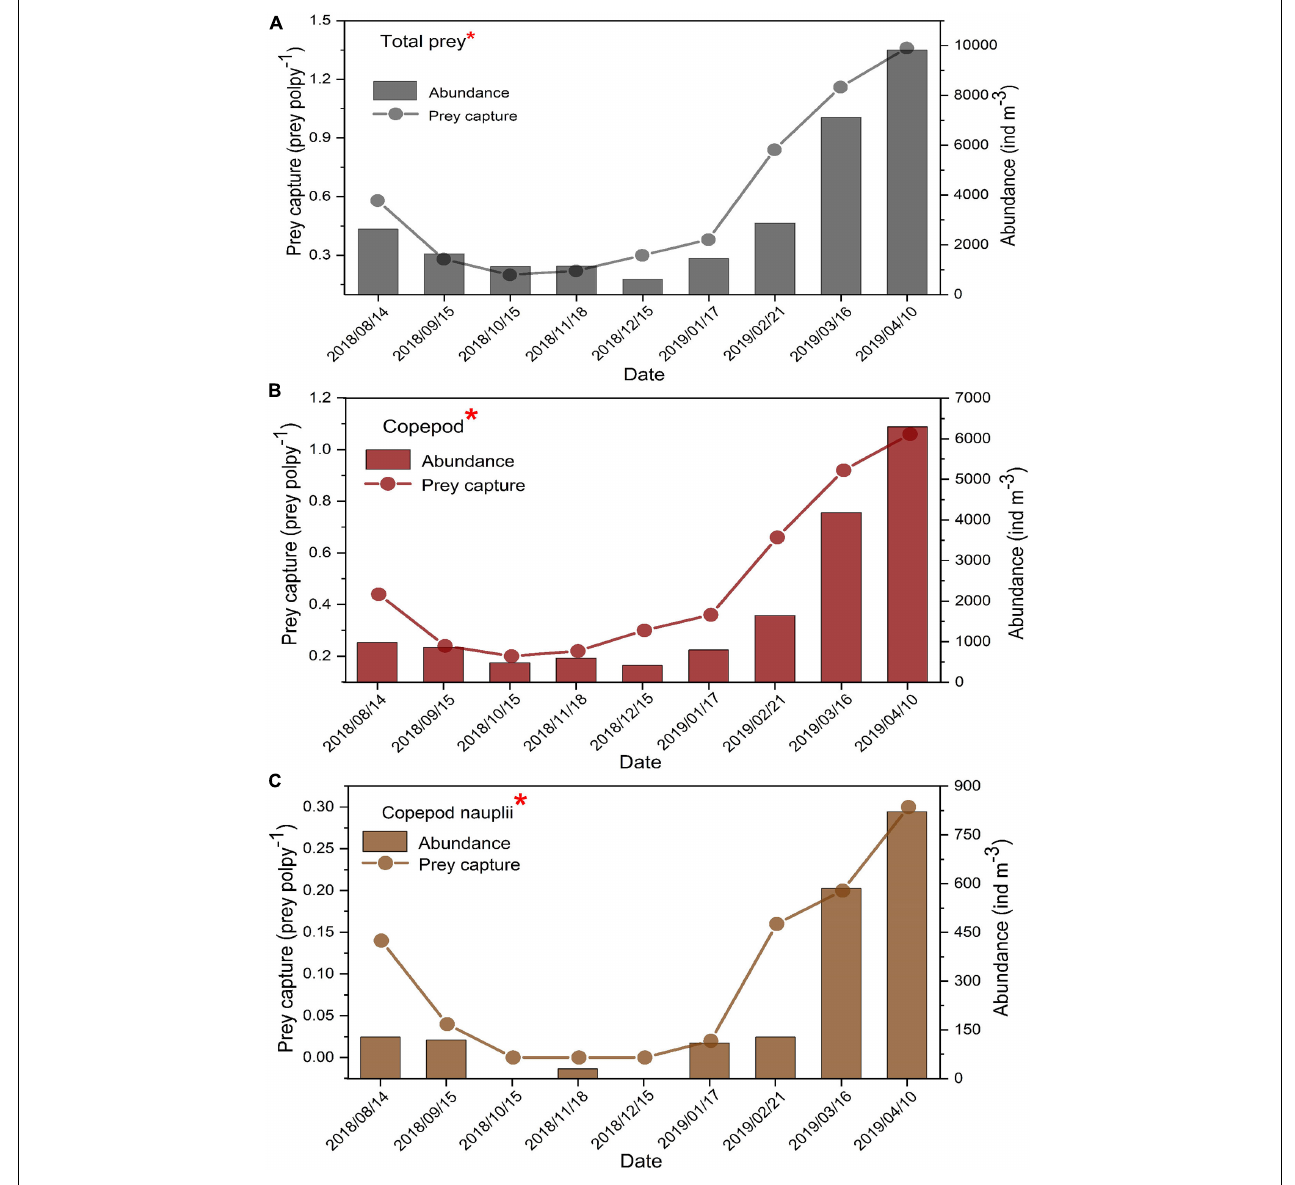
FIGURE 7 | The relationship between prey capture (prey polyp − 1 ) and zooplankton abundance (ind m − 3 ) [total prey (A) , copepods (B) , and copepod nauplii (C) ] during August 2018 to April 2019 sampling period. *Spearman correlation tests showed that the prey capture was significantly correlated with zooplankton abundance. Table 2 shows the results of the Spearman correlation